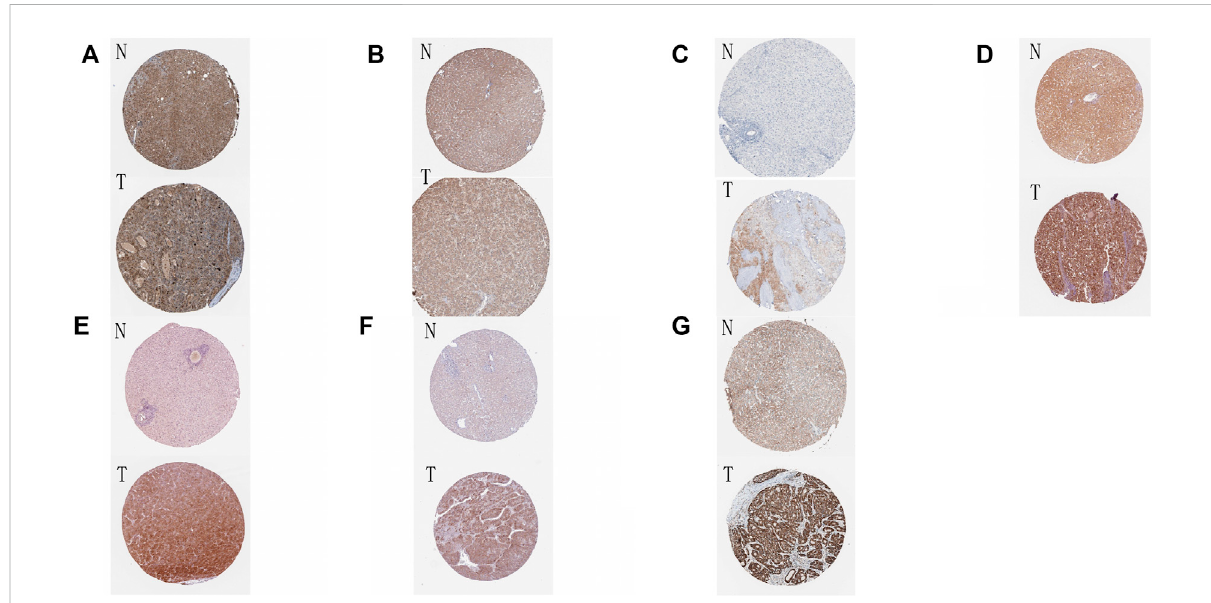
FIGURE 4 Immunohistochemical resultsofeightgenesintumortissuesandnormaltissues (A – G) Theimmunohistochemicalexpressionofeightgenesin normal tissues and HCC tissues in HPA online database. N: normal tissue, T: HCC tissue. (A) ATG 12; (B) MFN1 ; (C) OPTN ; (D) PGAM5 ; (E) SQSTM1 ; (F) TOMM5 ; (G) TOMM22 .